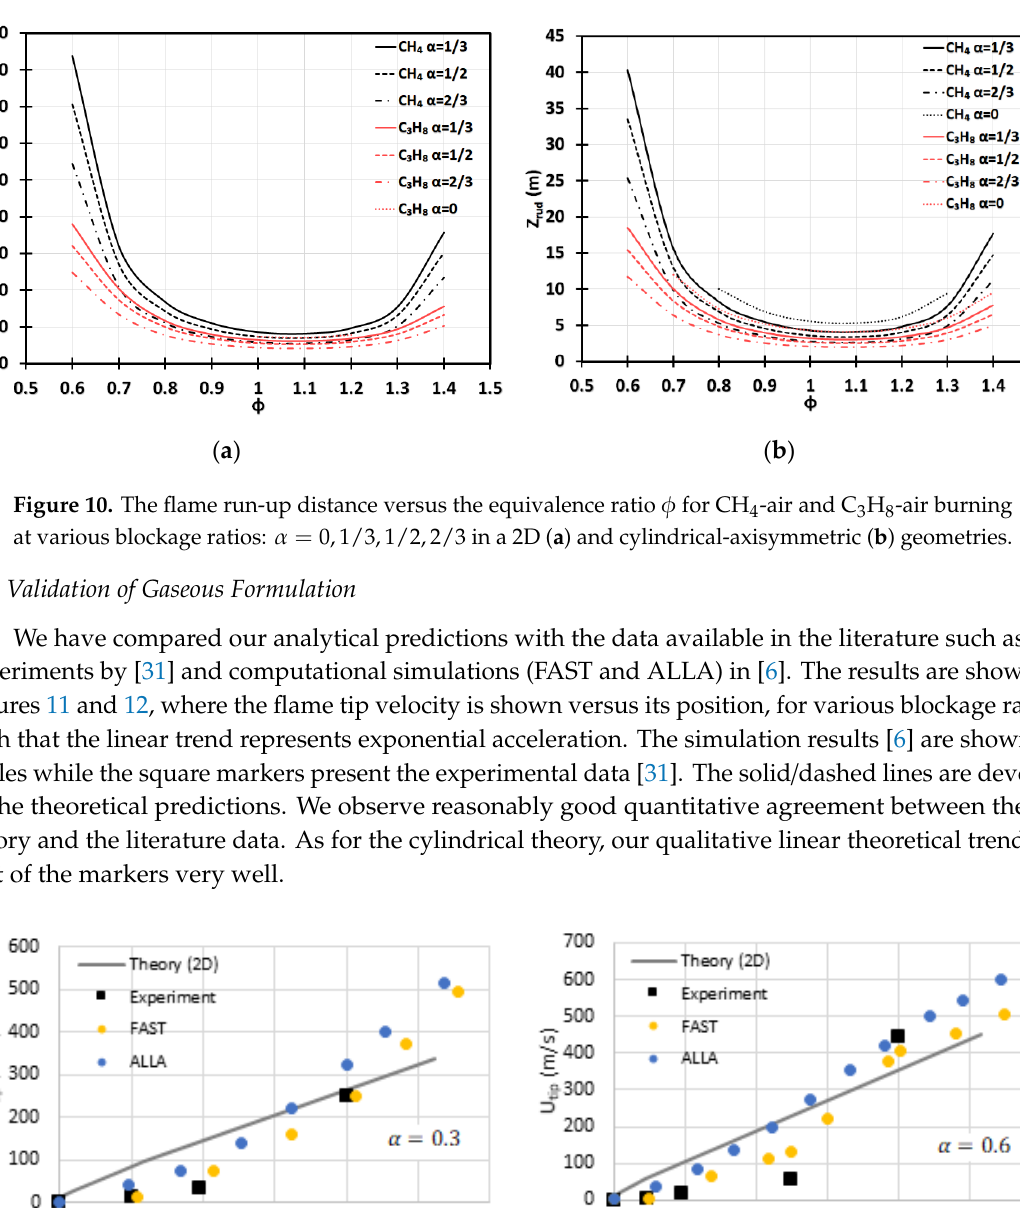
Figure 12. Comparison of our theoretical formulation with the experiments [31] and computational simulations [6] (FAST, yellow, and ALLA, blue). The flame tip velocity vs. its position for the blockage ratios (cid:2009) = 0.3 ( a ) and 0.6 ( b ). 3.3. Extension to Gaseous-Dusty Environment Starting with homogeneously gaseous combustion in the previous subsection, we next extend our analysis to a gaseous-dusty environment by using a modified version of the Seshadri formulation [10], which expresses the laminar flame velocity as a function of local thermal-chemical properties of the gas and dust particles (inert, such as sand; combustible, i.e., coal; and combined) in the form (cid:1847) (cid:3033) → (cid:1847) (cid:3031),(cid:3033) [3]: